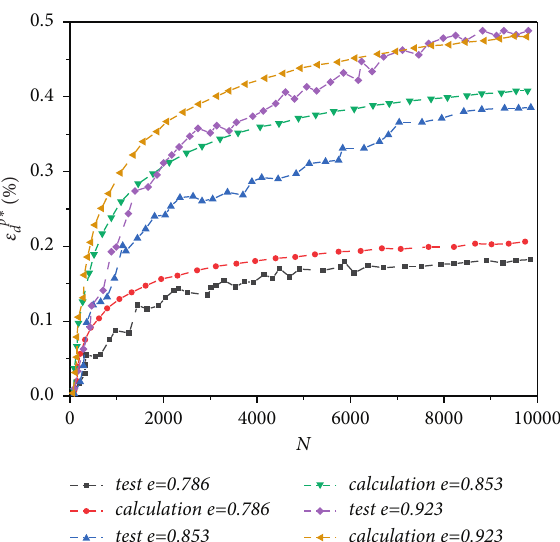
Figure 12: N − ε p ∗